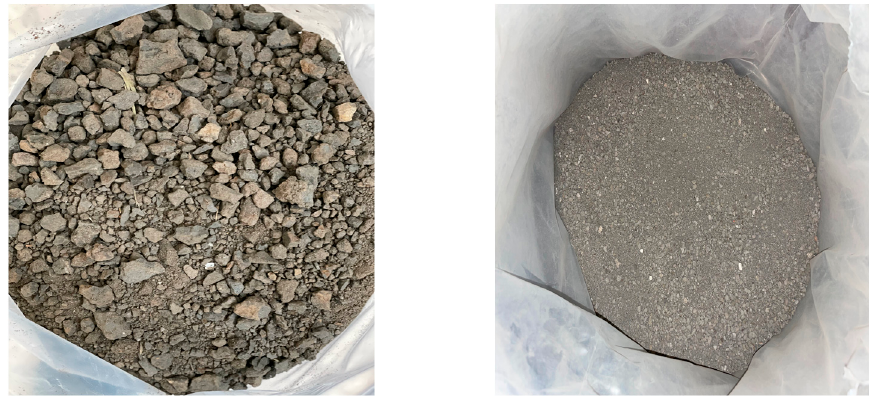
Figure 1. Illustration of raw materials (in left ) and sediment (in right ) RCA .